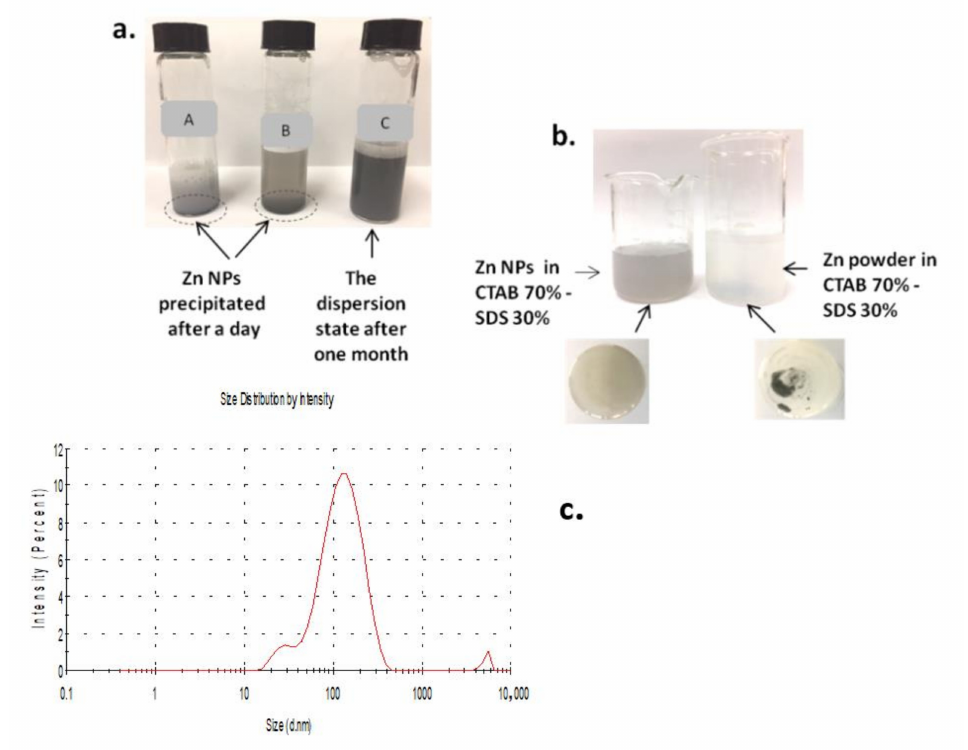
Figure 4. ( a ) ZnNPs in different proportions of surfactants A—CTAB 30%–SDS 70%; B—SDS 100%; C—CTAB 70%–SDS 30%. ( b ) ZnNPs and Zn power in CTAB–SDS surfactant mixture. ( c )